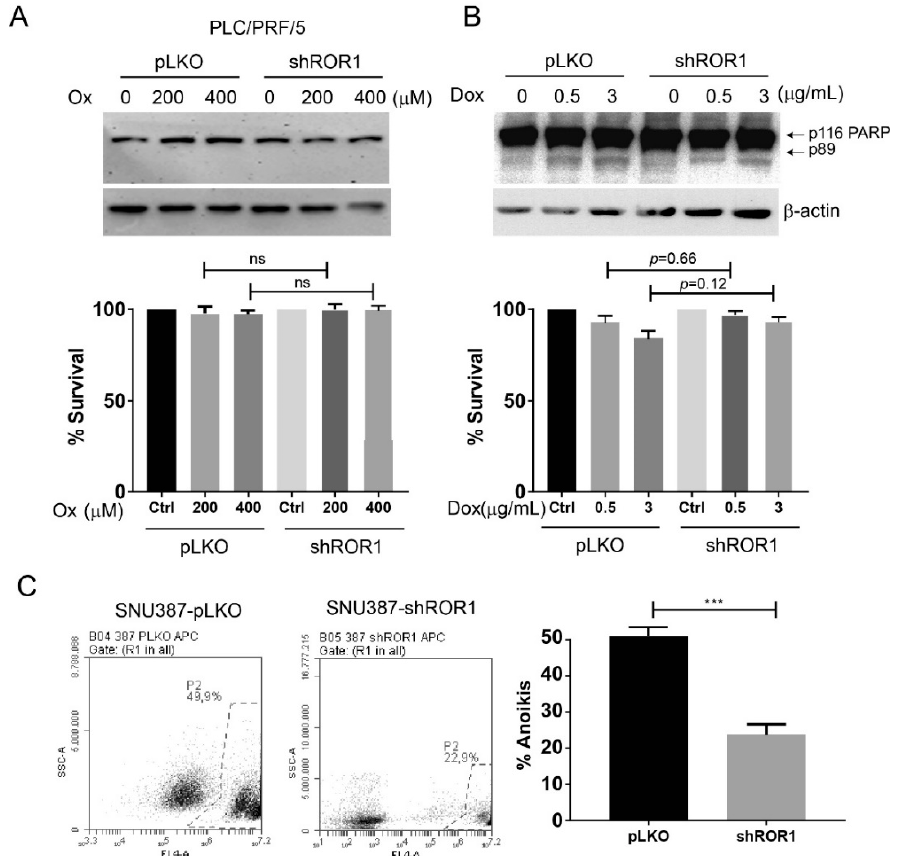
Figure A2. Analysis of resistance to apoptosis and anoikis in 387-shRNA ROR1-knockdown and 387-control clones. ( A ) 387-shRNA ROR1-knockdown and control clones were treated with various concentrations of Oxaliplatin for 24 h. PARP antibody was used to detect apoptosis. Protein band intensity of cleaved PARP was measured by ImageJ to detect the ratio of dying/surviving cells under drug treatment. ( B ) 387-shRNA ROR1-knockdown and control clones were treated with various concentration of Doxorubicin for 24 h. PARP antibody was used to detect apoptosis. Protein band intensity of uncleaved PARP was measured by ImageJ to detect the ratio of surviving cells under drug treatment. β -actin antibody was used as a loading control. ( C ) 387-shRNA ROR1-knockdown and control clones were seeded into ultra-low attachment plates and the ratio of apoptotic cells was calculated after 24 h via flow cytometry by using annexin V antibody. *** p < 0.05.